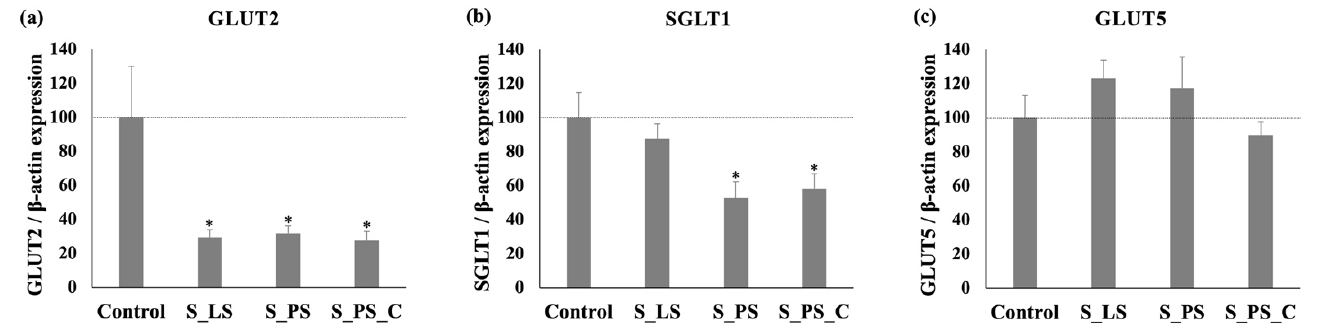
Figure 5. Quantification of mRNA levels of facilitative glucose transporter 2 (GLUT2) ( a ), sodium– glucose linked transporter 1 (SGLT1) ( b ), and facilitative glucose transporter 5 (GLUT5) ( c ), by qRT-PCR in Caco-2 cells after treatment for 24 h with 1 mg/mL of S_LS, S_PS, and S_PS_C extracts ( n = 6 for each) or the respective solvent (control, DMSO; n = 5). Results are shown as the expression of SGLT1, GLUT5 or GLUT2 relative to β -actin (arithmetic means ± SEM). * Significantly different from control ( p < 0.05).